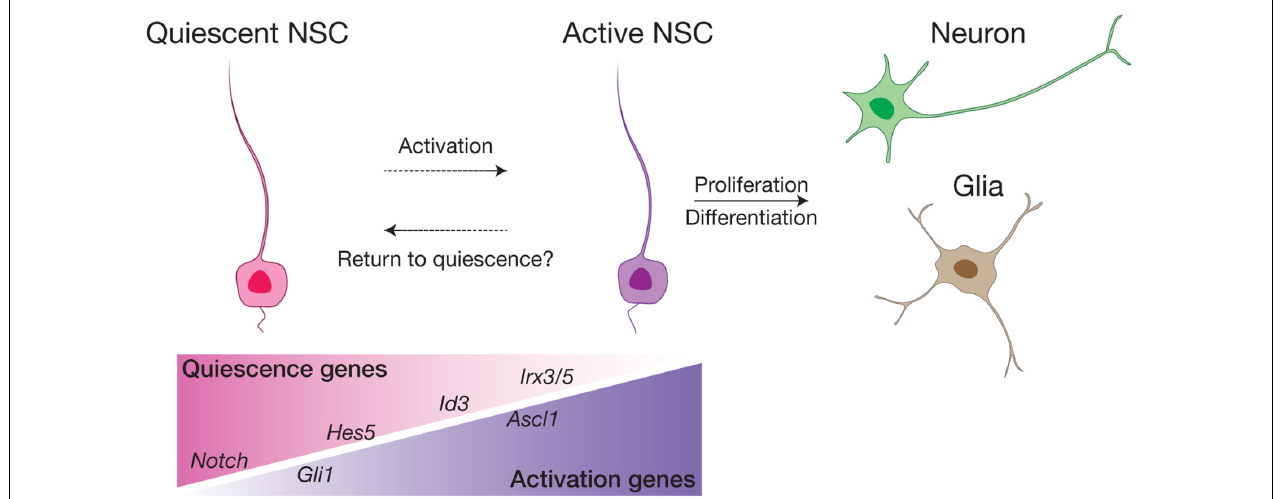
FIGURE 5 | Schematic model of NSC quiescence and activation. In the SVZ and SGZ neurogenic niches, the majority of adult NSCs are quiescent and can be activated by various factors to proliferate and differentiate into neurons and glia. We postulate that in the ventral hypothalamus, RGL-NSCs are mostly in a quiescence state enriched in Notch ligand, Hes5 and Id3 expression. Irx3 and Irx5 are likely novel factors involved in maintaining the quiescence of RGL-NSCs in the postnatal hypothalamus. Sub-populations of primed RGL-NSCs expressing Gli1 , and active NSCs marked by Ascl1 also exist in small